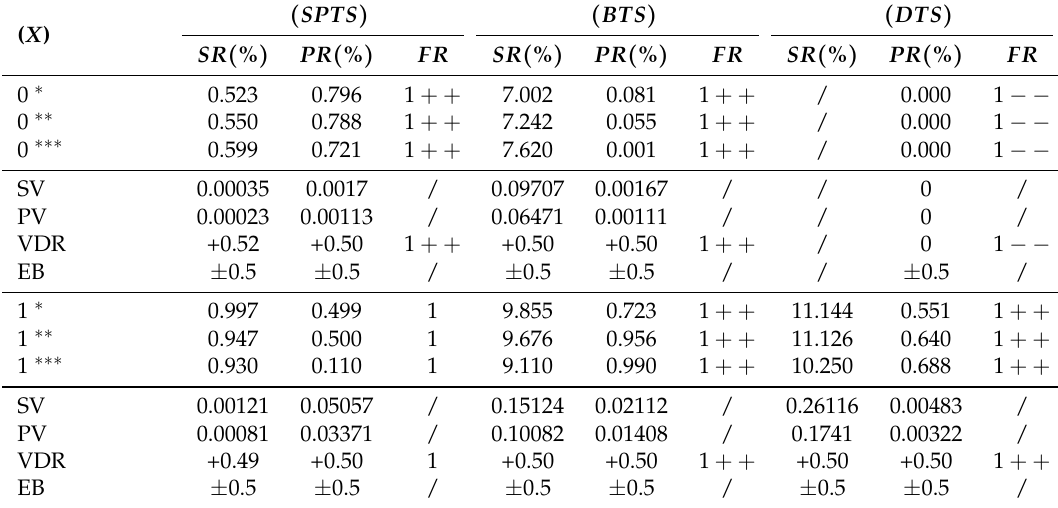
Table 5. Quantum simulation of high-dimensional data tables describing the three topological structures of the DE algorithm implied in β -Hilbert space about X